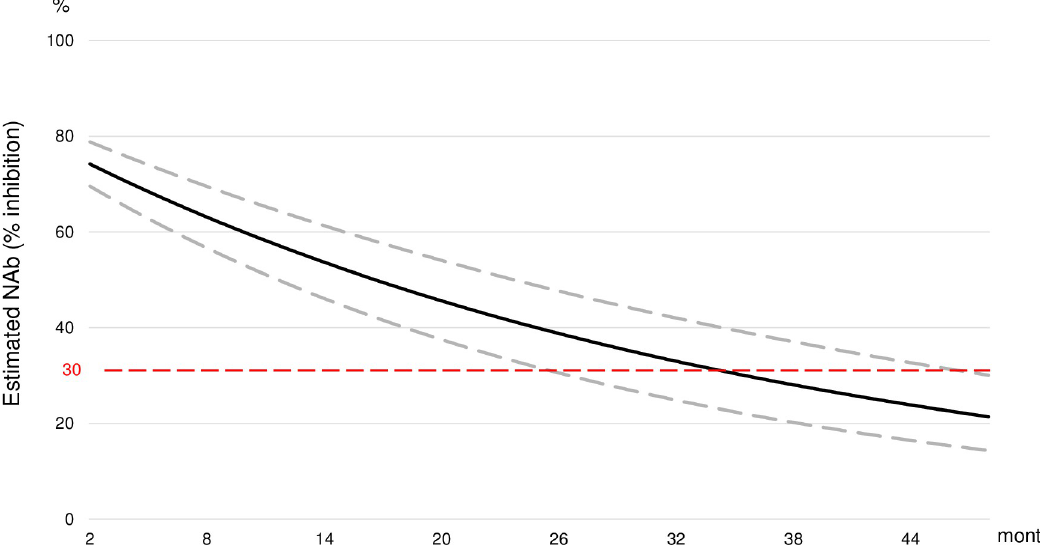
Fig 3. The estimated decay curve of best fit for neutralizing antibody (NAb). The solid line indicates the estimated level of the NAb and dotted lines indicate the upper and the lower bounds of the 95% confidence intervals. The red dotted line indicates the cutoff line for 30% of